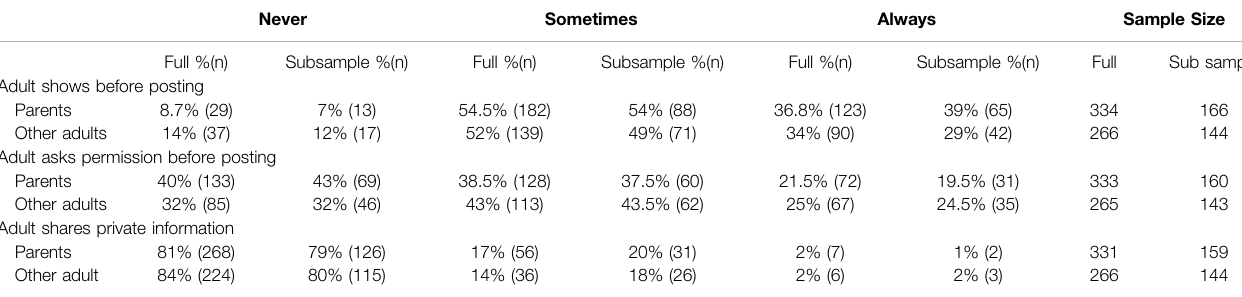
TABLE 2 | Frequency of parent and other adult privacy-respecting behaviors.